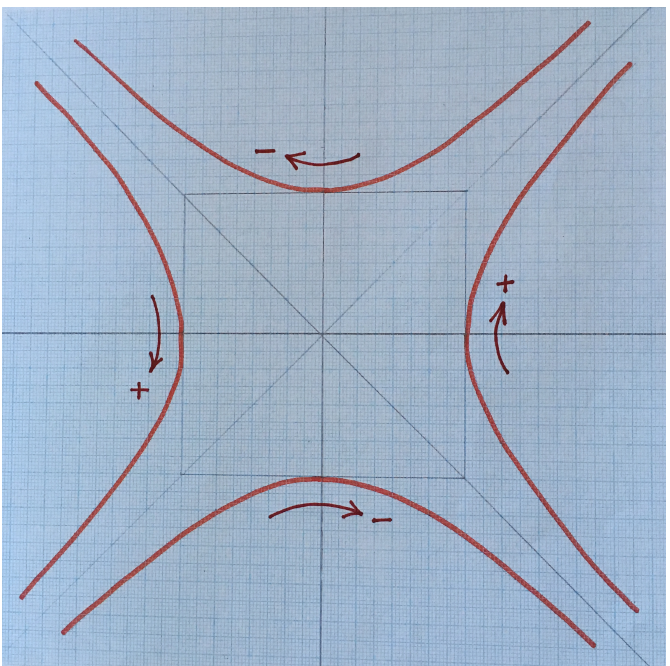
Figure 8. On orienting the unit circle.